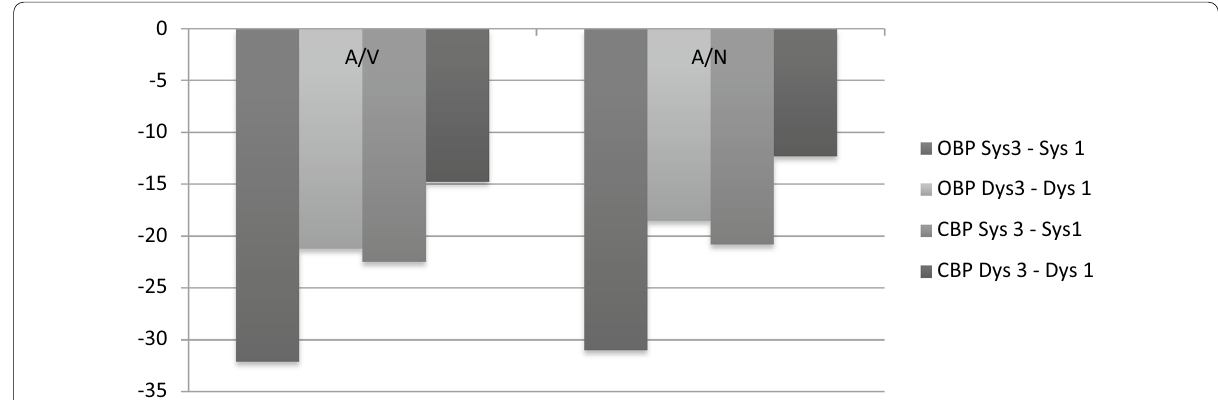
Fig. 2 Mean differences of BP within the same group and between